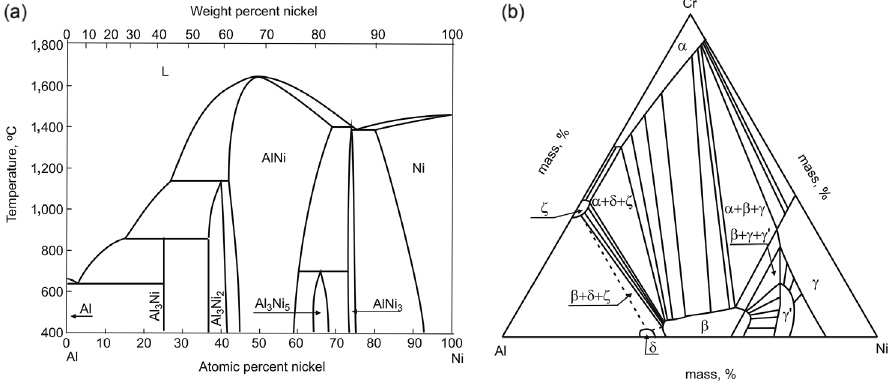
Figure 4: (a) Al-Ni phase diagram [14], (b) Al-Ni-Cr phase diagram at 1,025 °C (after [15]).